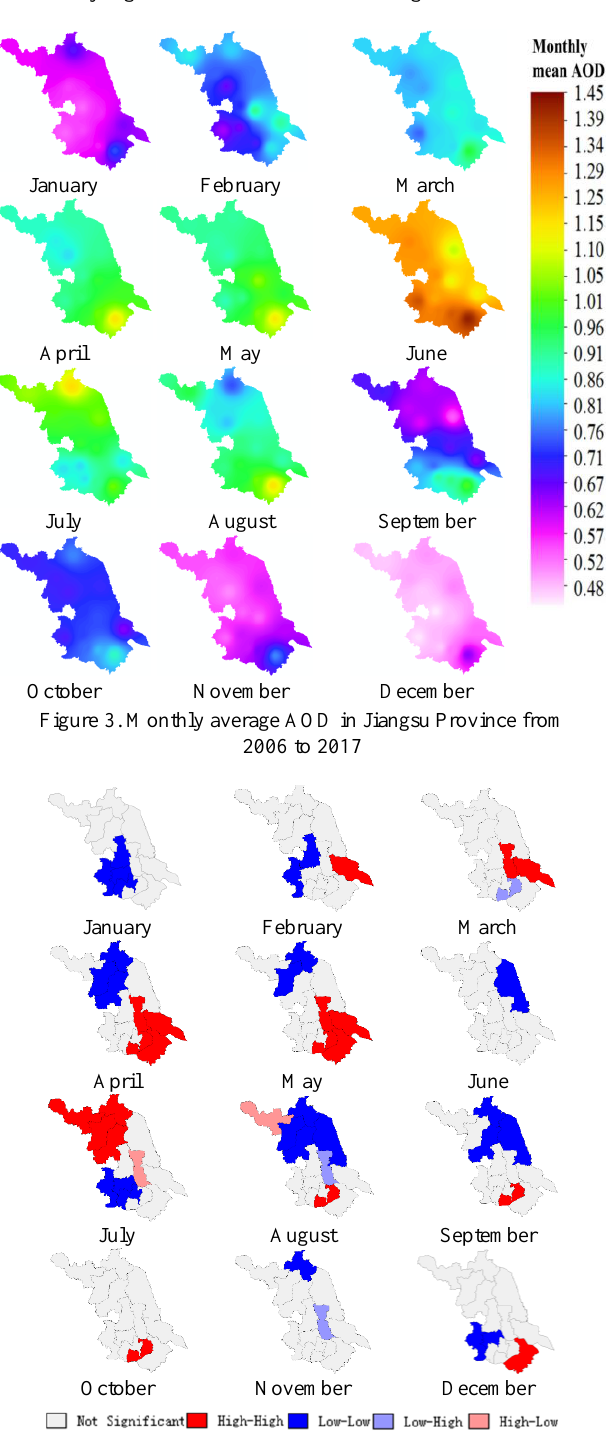
Figure 4. LISA map of monthly average AOD in Jiangsu Province from 2007 to